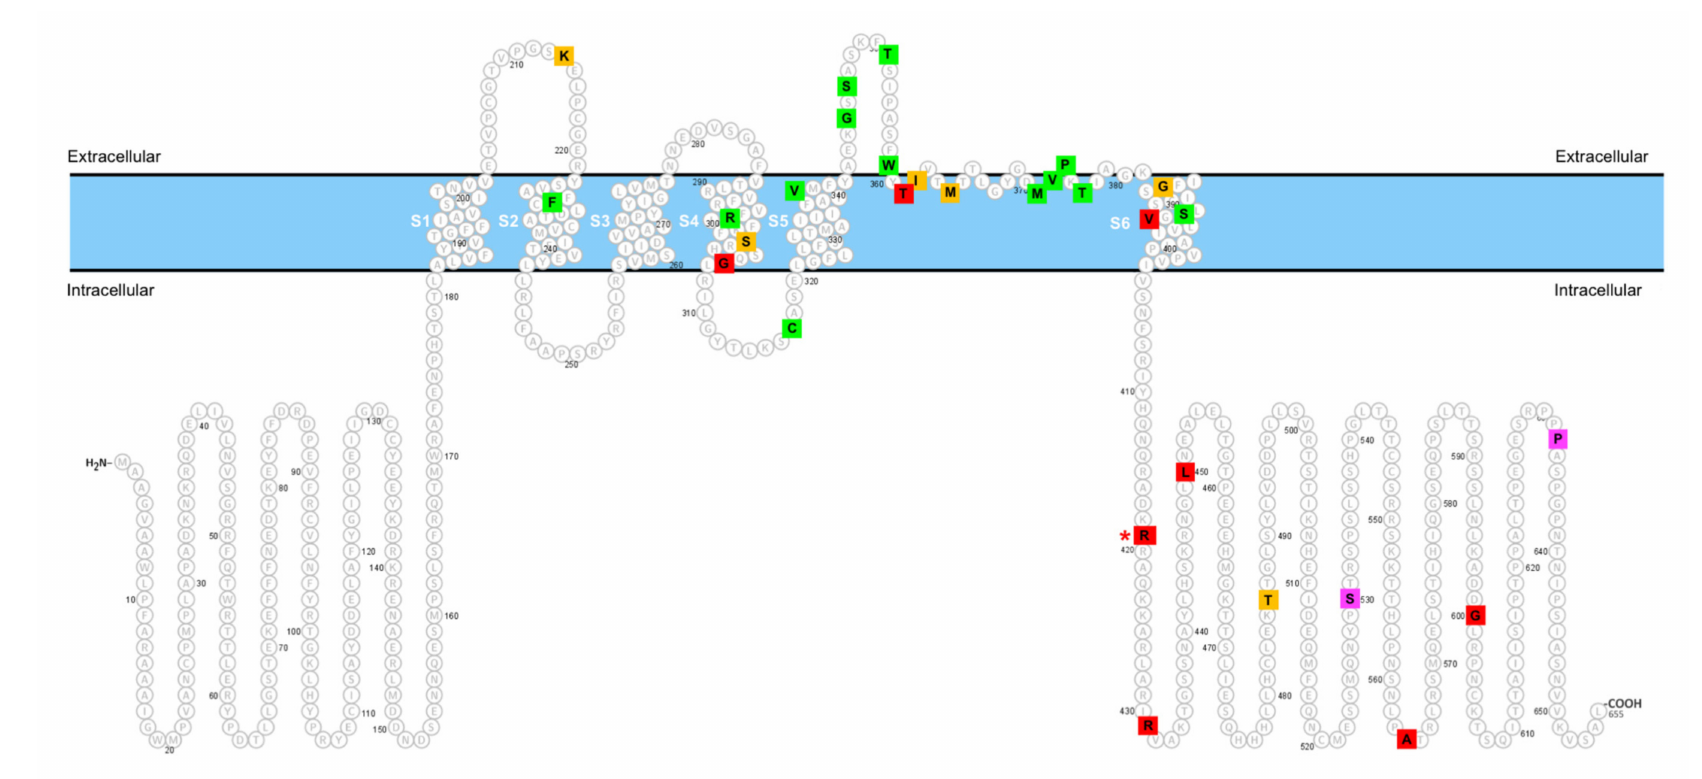
Figure 5. Topographic representation of disease-associated KCND3 variants in the K V 4.3 subunit. Green and red symbols represent K V 4.3 variants with loss-of-function and gain-of-function phenotypes, respectively. Magenta symbols indicate K V 4.3 variants with no significant alteration of functional properties. Yellow symbols refer to K V 4.3 variants that have yet to be functionally characterized. The red asterisk denotes the p.R419H variant studied in the current report. See Table 3 for genotype–phenotype